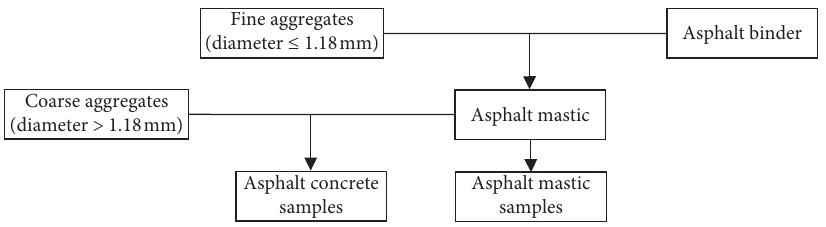
Figure 8: Preparation process of asphalt concrete samples and asphalt mastic samples.